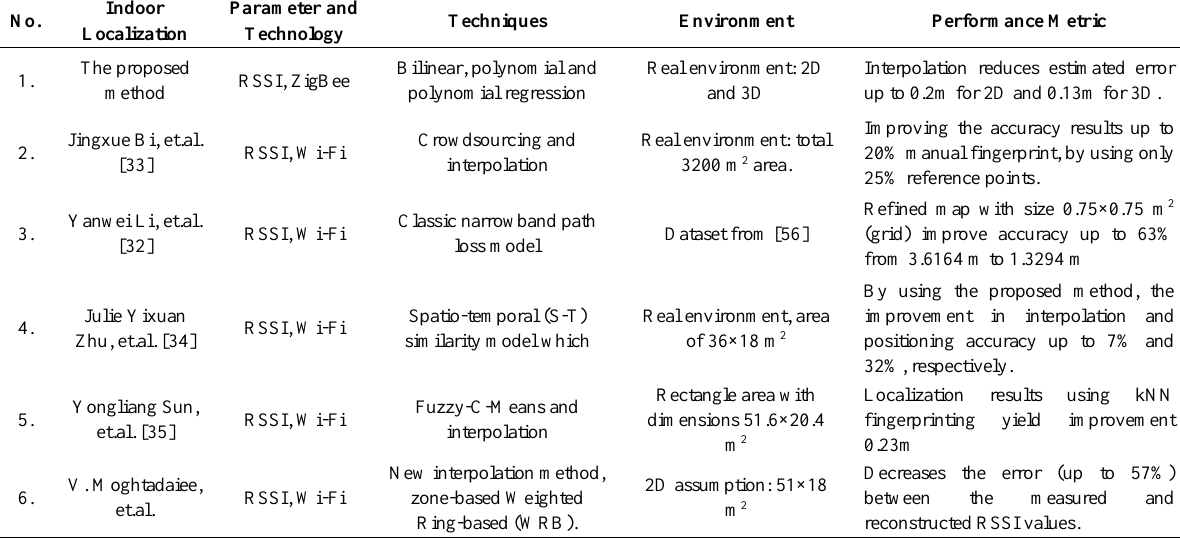
Table 5. Performance Comparison with Other